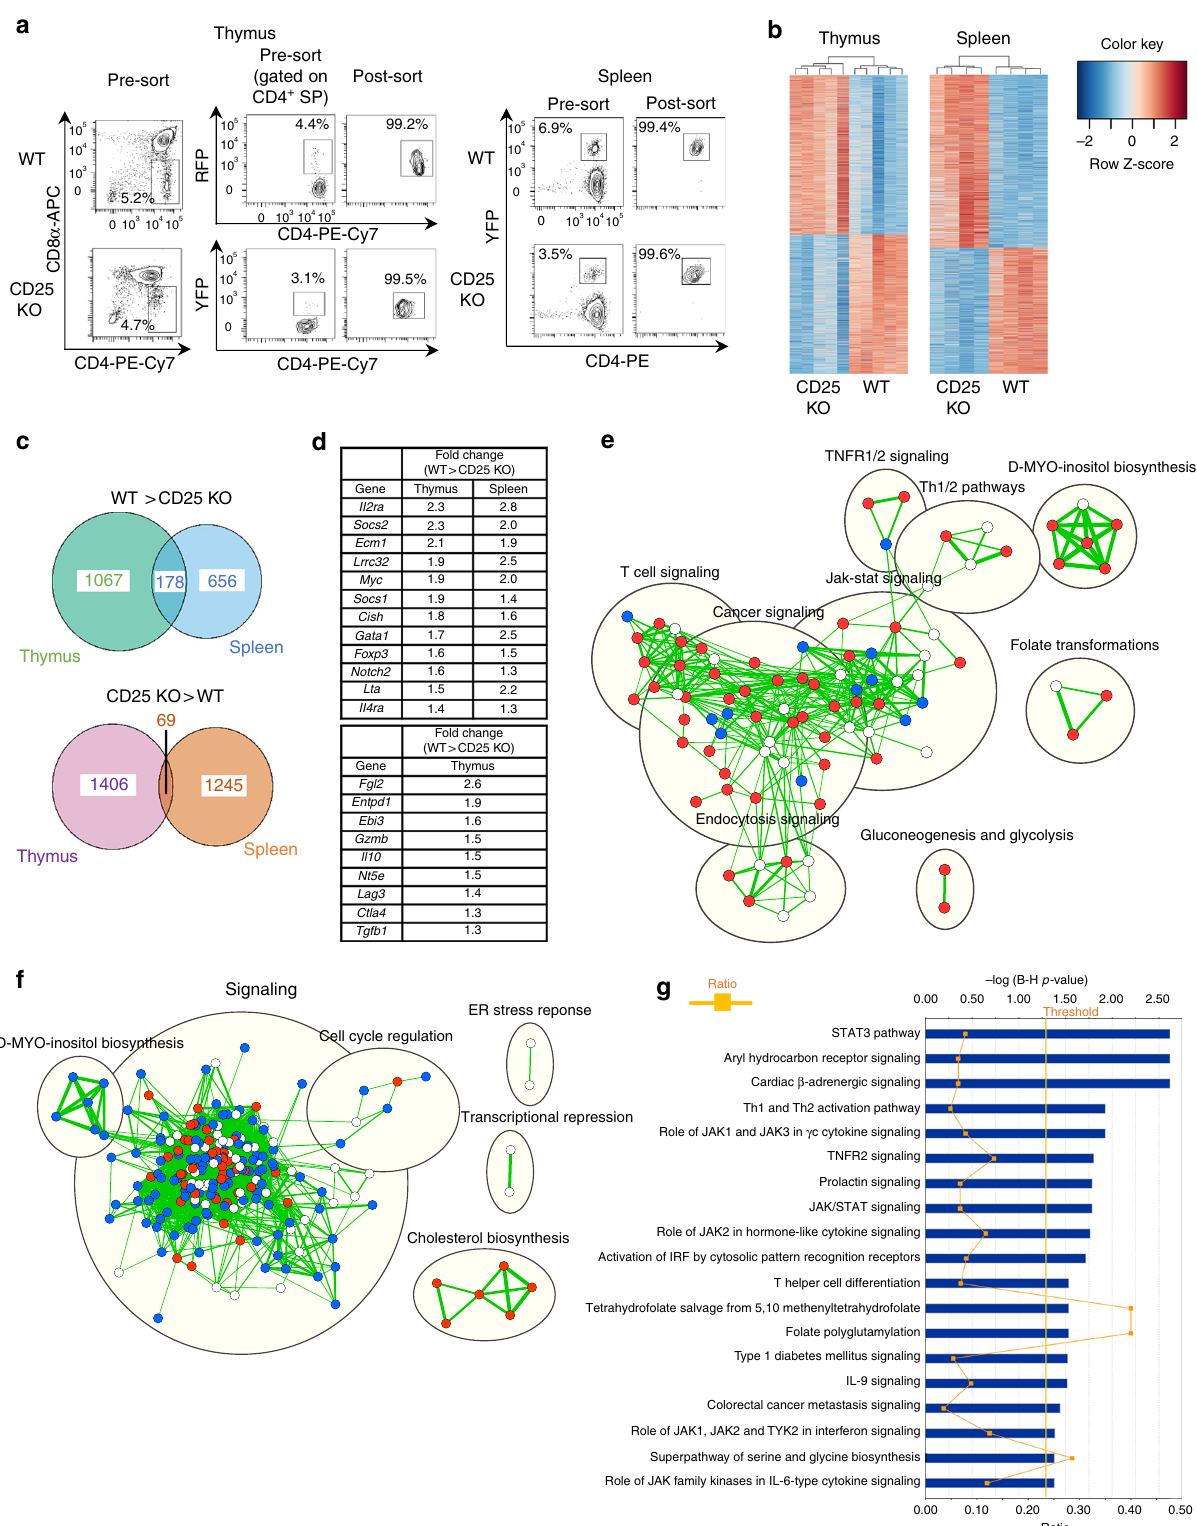
YFP + Tregs from CD25 fl ox/Foxp3eGFP-Cre-ERT2/R26Y mice were ~50%. Ki67 expression was increased twofold at the mRNA level, FACS-puri fi ed and stained for Foxp3, Ki67, and Bcl-2 by while protein expression was indistinguishable between CD25 KO intracellular fl ow cytometry. Foxp3 expression among peripheral and WT Tregs (Fig. 8a, b). Collectively, these results suggest that CD25 KO Tregs was reduced by ~30% at the mRNA and protein abrogation of IL-2R signaling impairs survival of Tregs, levels, while Bcl-2 mRNA and protein expression were reduced by particularly cTregs, while leaving proliferative function intact. NATURE COMMUNICATIONS| (2019) 10:1037